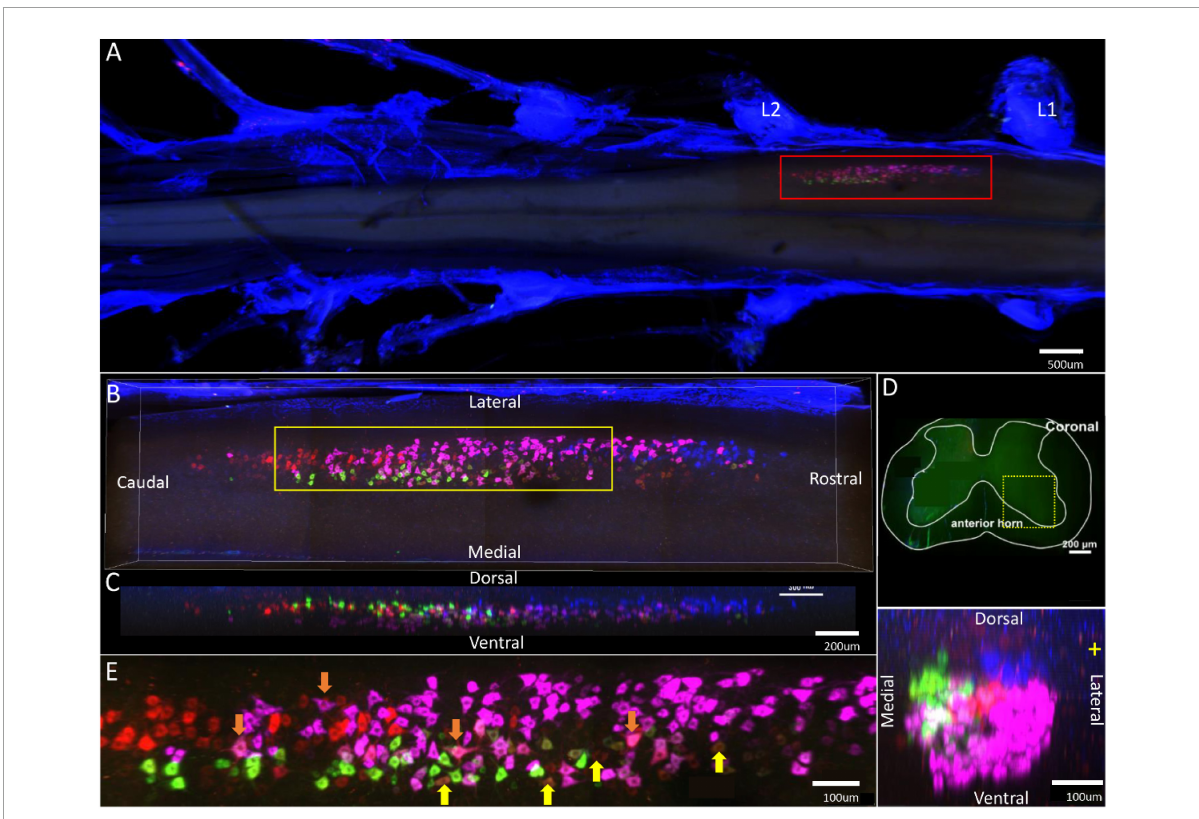
FIGURE7 Distribution characteristics of motor neurons targeting different muscles innervated by sciatic nerves. Motor neurons innervating gastrocnemius (labeled by FR, red), tibialis anterior (labeled by FG, blue), soleus (labeled by CTb-488, green), peroneus longus/brevis (labeled by CTb-647, purple). (A) Spatial images of multi-tracks in a holistic view. (B,C) The relative spatial positions of the motor neuron columns targeting different muscles in sagittal and corona viewing angles. The yellow box that outlines the region of interest is shown in panel (E) . (D) The schematic diagram of the distribution of different motor neuron columns in the anterior horn of the spinal cord. The yellow box that outlines the region of interest is amplified in the subpanels in panel (D) . The cross-sectional images are maximum projections of L1–2. (E) Motor neurons, which innervate gastrocnemius and soleus, are some double-labeled (Yellow arrow). Motor neurons, which innervated gastrocnemius and peroneus longus/brevis, are some double-labeled (Orange